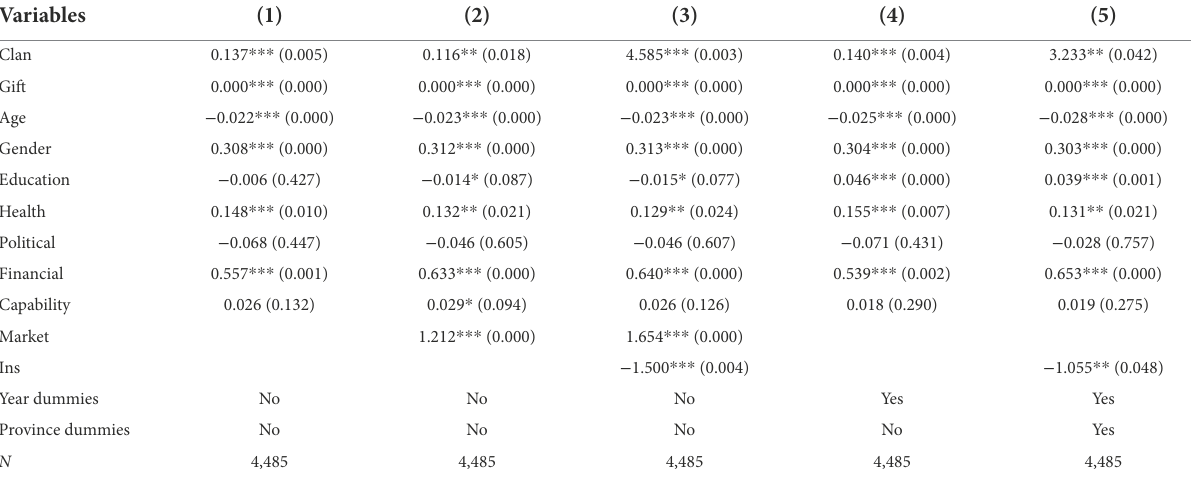
TABLE 3 The effect of clan on farmers’ entrepreneurial